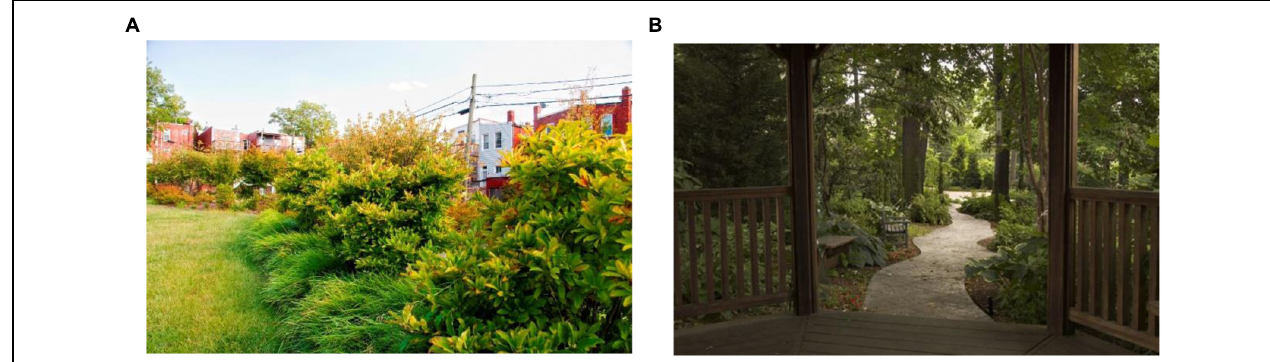
FIGURE 2 | Comparison of two images in their color diversity properties. (A) Example of an image with high variation in saturation and medium variations in hue and brightness. SDHue = 0.19, SDSat = 0.38, SDBright = 0.28. (B) Example of an image with low variation in saturation and hue and medium variation in brightness. SDHue = 0.05, SDSat = 0.16, SDBright = 0.15.